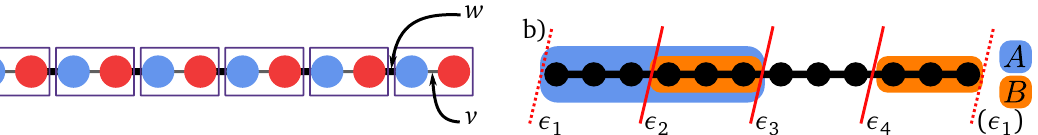
Figure 1: (Color online) The SSH chain and the partition used for S D . a) The SSH chain is a spinless fermionic chain of sites A and B (blue and red on the figure) connected with staggered hoppings v and w . A pair of sites A and B forms a unit cell (a box on the figure). b) Partitions A (shaded, blue) and B (shaded, orange) associated with the entanglement topological order parameter S D . For large systems, the exact locations of the cuts ε , i = 1,2,3,4, of each partition do change the value i of the bipartite entanglement entropy but do not change S D